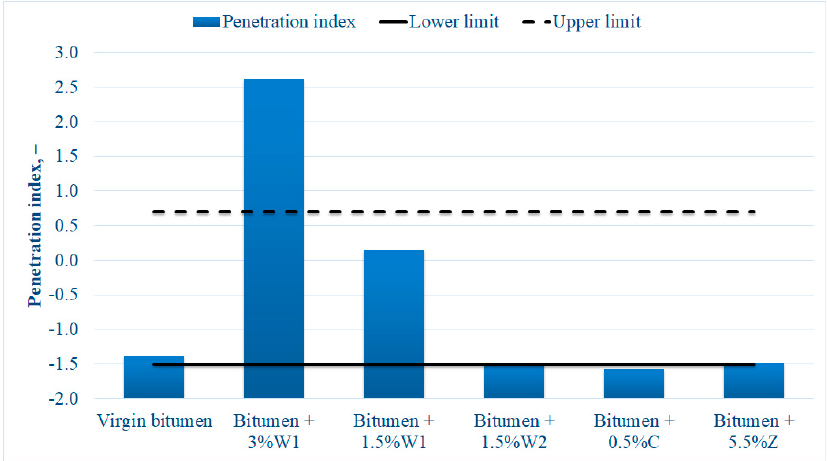
Figure 2. Penetration index values for different bitumen blends.